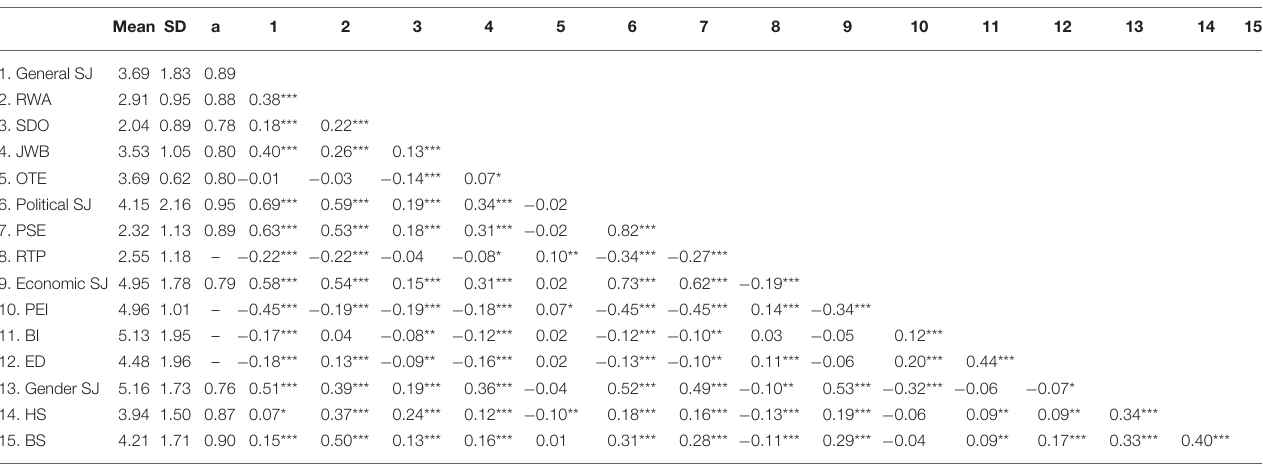
TABLE 7 | Correlational analysis